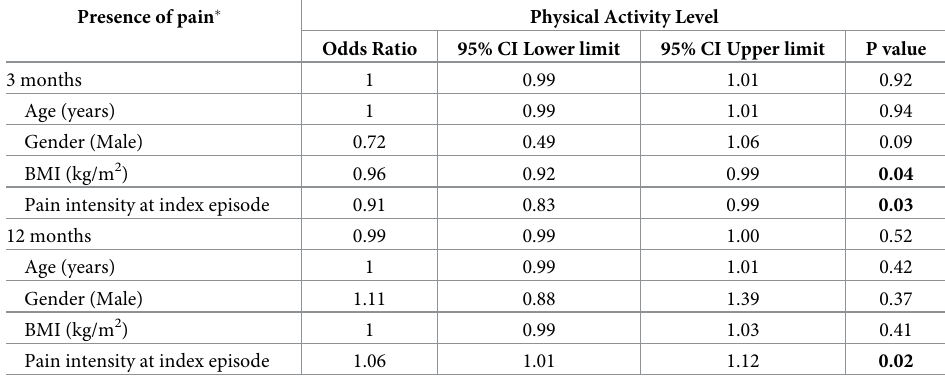
Table 3. Association between physical activity level (total MET minutes per week) before index episode and the presence of low back pain 3 months and 12 months after the index episode. Presence of pain � Physical Activity Level Odds